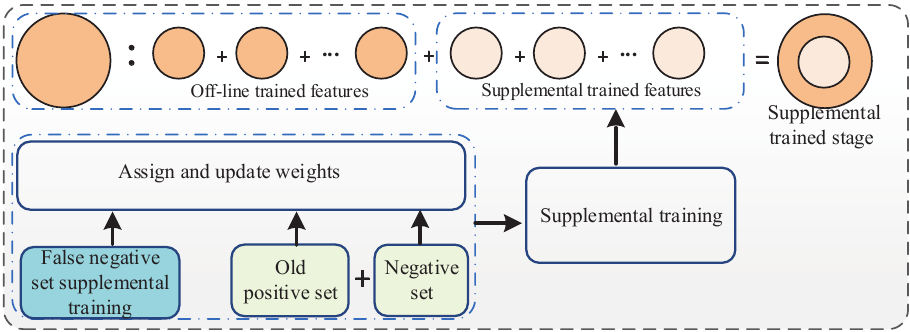
Figure 4. The process of training a supplemental trained